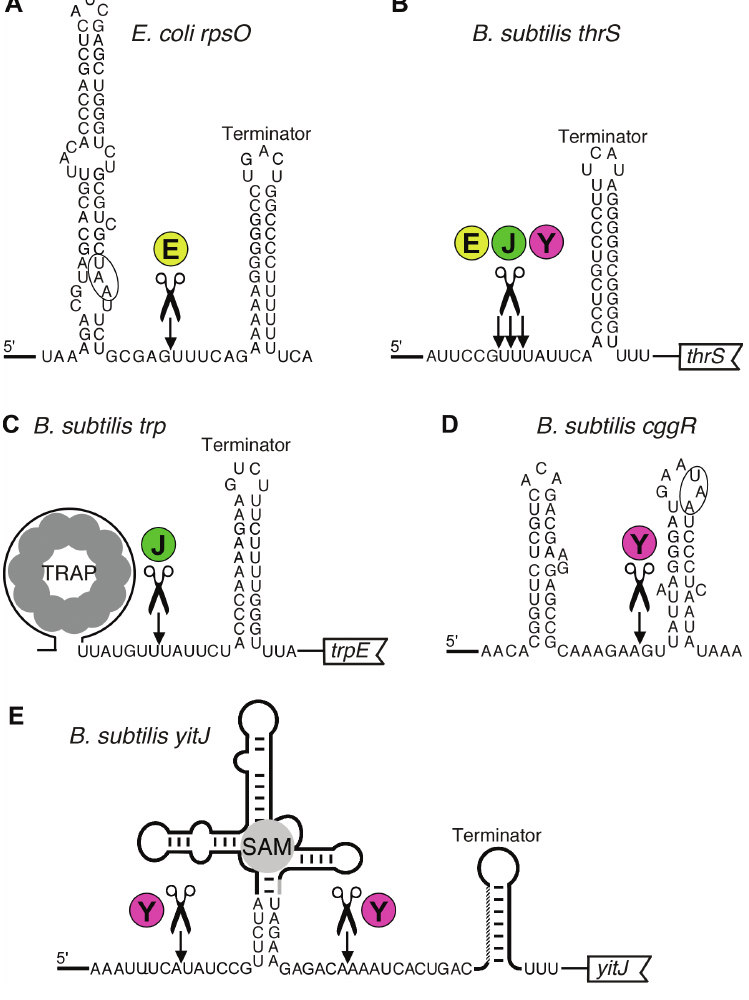
Figure 1 Endonucleolytic cleavage sites of RNases E, J and Y on natural substrates. (A) Decay initiating internal RNase E cleavage in vivo of the 3 9 UTR of the rpsO mRNA (118, 119). (B) Cleavage of the B. subtilis thrS mRNA 5 9 -UTR upstream of the leader terminator in vitro by RNases E, J and Y. Cleavage in vivo probably mediated essentially by RNase Y (unpublished observations). (C) Processing of the B. subtilis trpE 5 9 attenuator region by RNase J1 initiating the recycling of the TRAP regulatory protein (120). (D) In vivo cleavage by RNase Y within the B. subtilis cggR coding region, uncoupling cggR expression from that of the downstream gapA gene (21). (E) RNase Y cleavages in vivo and in vitro of the B. subtilis yitJ SAM riboswitch RNA initiating the decay of the SAM bound prematurely terminated leader RNA (20). Encircled triplets represent stop codons of the concerned